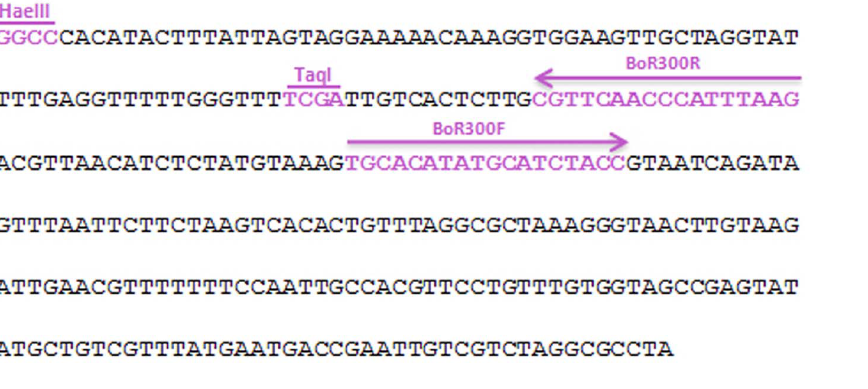
Figure 1. Nucleotide sequence of the monomer BoR300. The arrows indicate the outfacing primer pair: the reverse (BoR300-R) and the forward (BoR300-F) primer respectively. The restriction sites of the restriction endonucleases HaeIII and TaqI are also